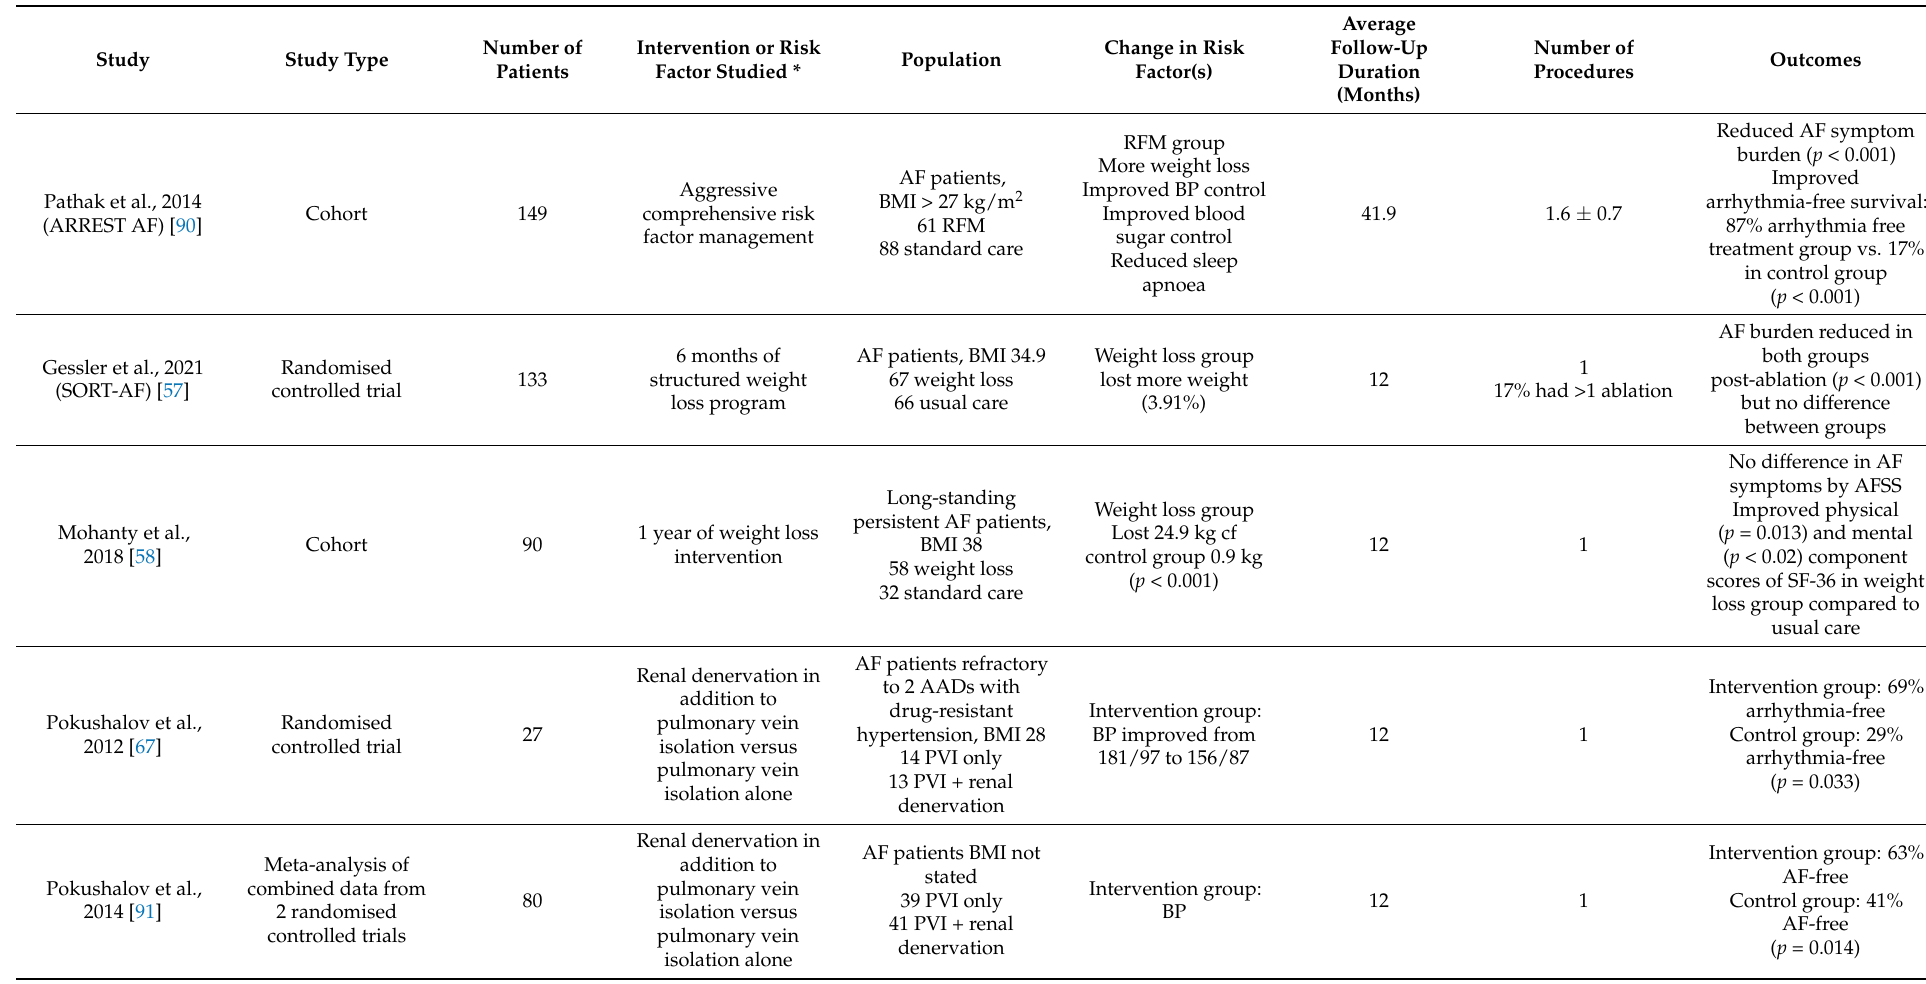
Table 2. Studies demonstrating evidence for risk factor management in patients undergoing AF